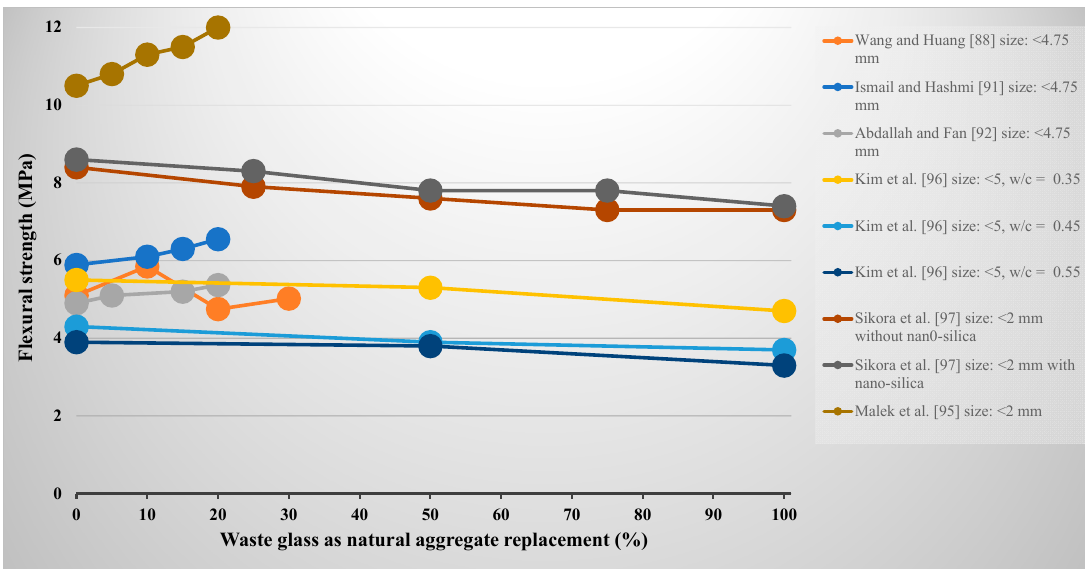
Figure 12. Effect of waste glass as a natural aggregate replacement on 28-days flexural strength.